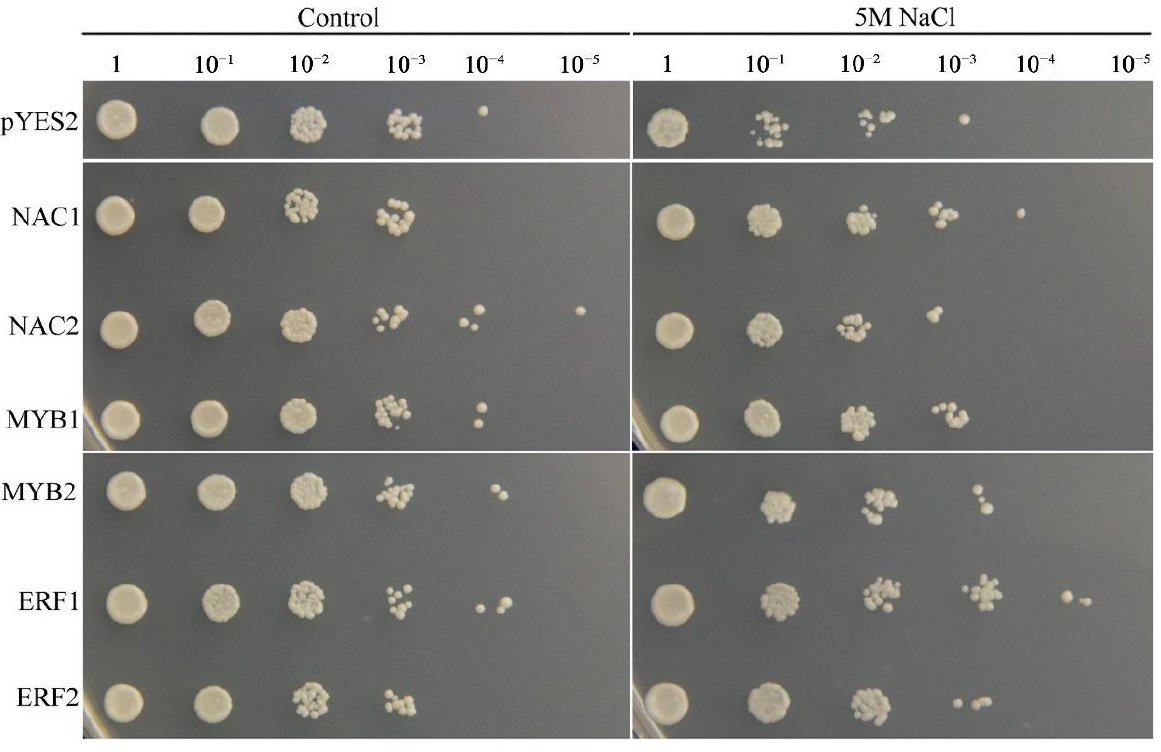
Figure 12. Phenotypic growth assays of Saccharomyces cerevisiae INVSc1 cells transformed with a pYES2 empty vector, NAC1;2 , ERF1;2 , or MYB1;2 were spotted on SC-Ura media in 2 mL aliquots of 10-fold serially diluted (1, 10 − 1 , 10 − 2 , 10 − 3 , 10 − 4 , and 10 − 5 ) cultures under salinity stress.